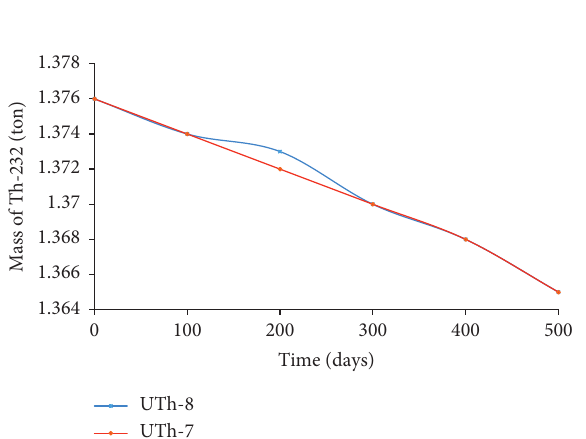
Figure 8: Neptunium production.